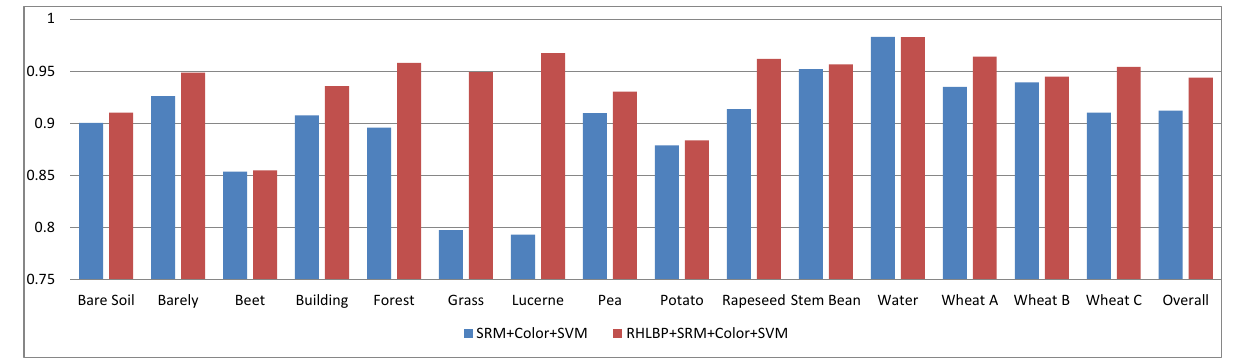
Figure 15. The classification accuracies of the SRM algorithm with color